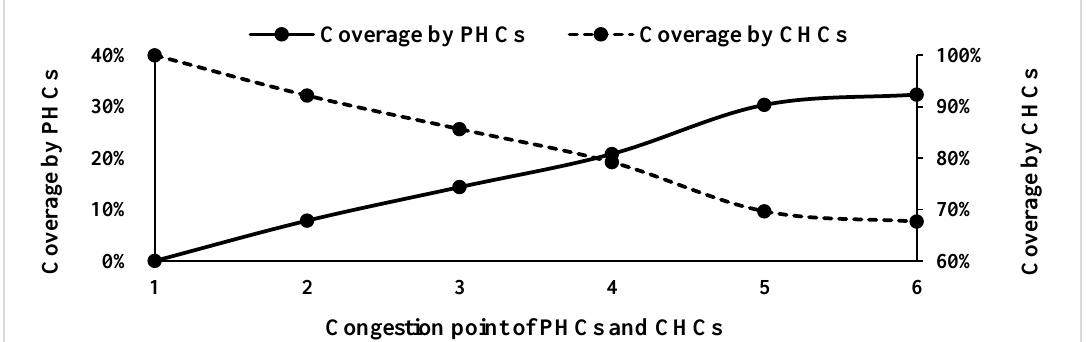
Figure 3. Congestion level vs. coverage